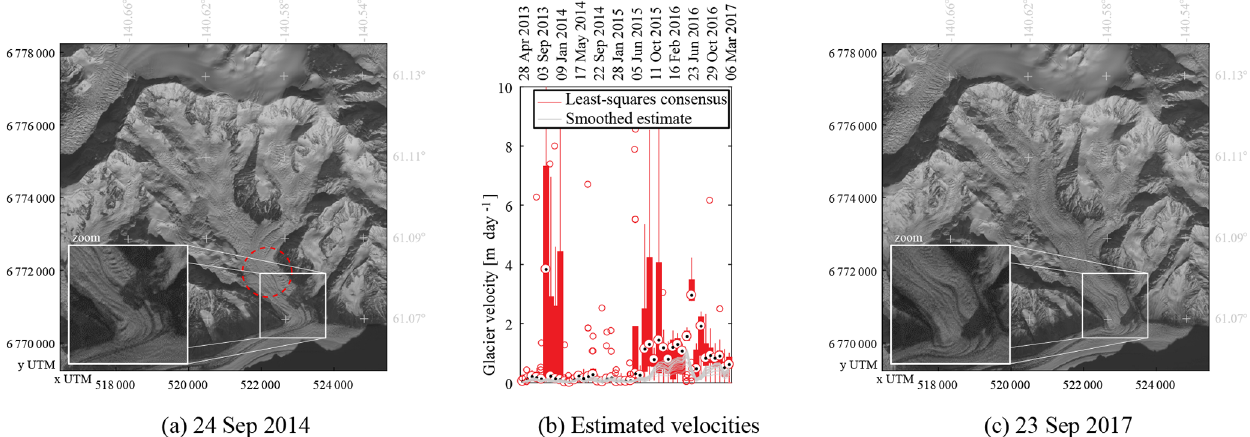
Figure C1. A tributary of Chitina Glacier surged in the period 2015–2016. Images are both acquired by Landsat 8; its location is indicated by a square in Fig. 13. The location of the time series in panel (b) is indicated by a red dashed circle in panel (a)